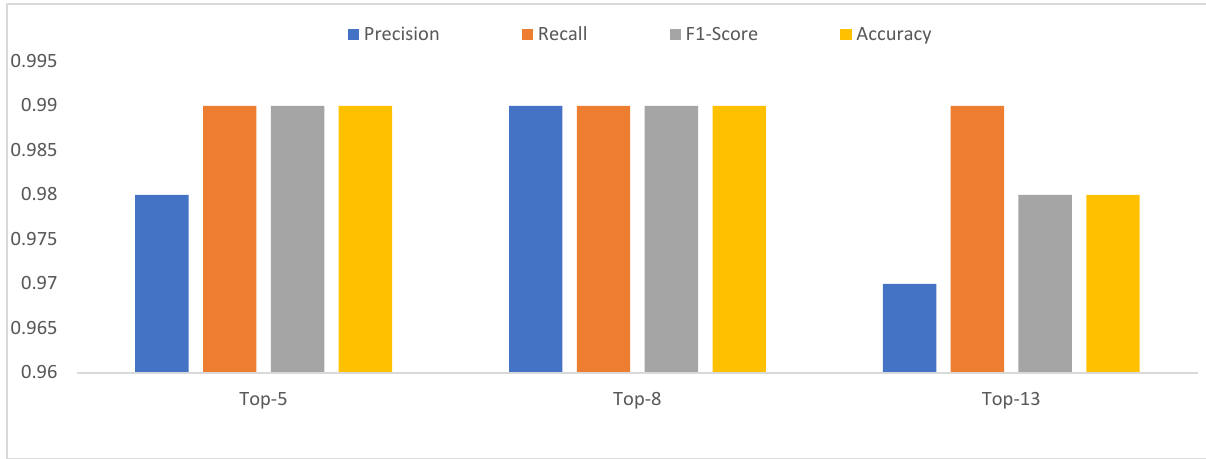
Figure 6. Difference in each group’s evaluation metrics.